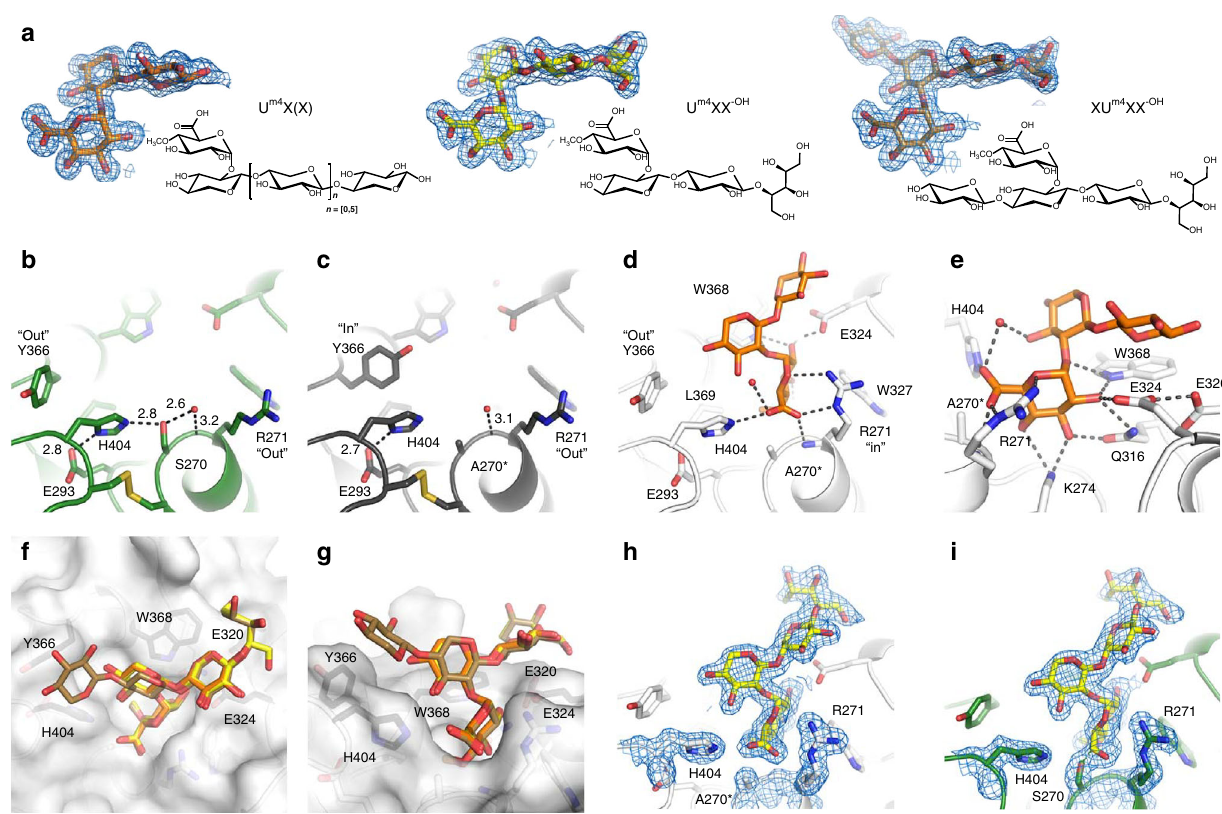
Fig. 4 Active site, crystallographic complexes, and XU m4 X-recognition. a Aldouronic acid ligands in the complexes d Δ S270A:U m4 X, d Δ S270A:U m4 XX -OH , and d Δ S270A:XU m4 XX -OH . 2F o – F c electron density maps for the re fi ned ligands are shown at the 1.0 σ level. b Apo- Δ *dWT with an intact active site (pH 5.5). Hydrogen bonds between residues in the catalytic triad are indicated. c Apo-d Δ S270A (pH ca. 7.5) with Y366 in a different conformation (molecule